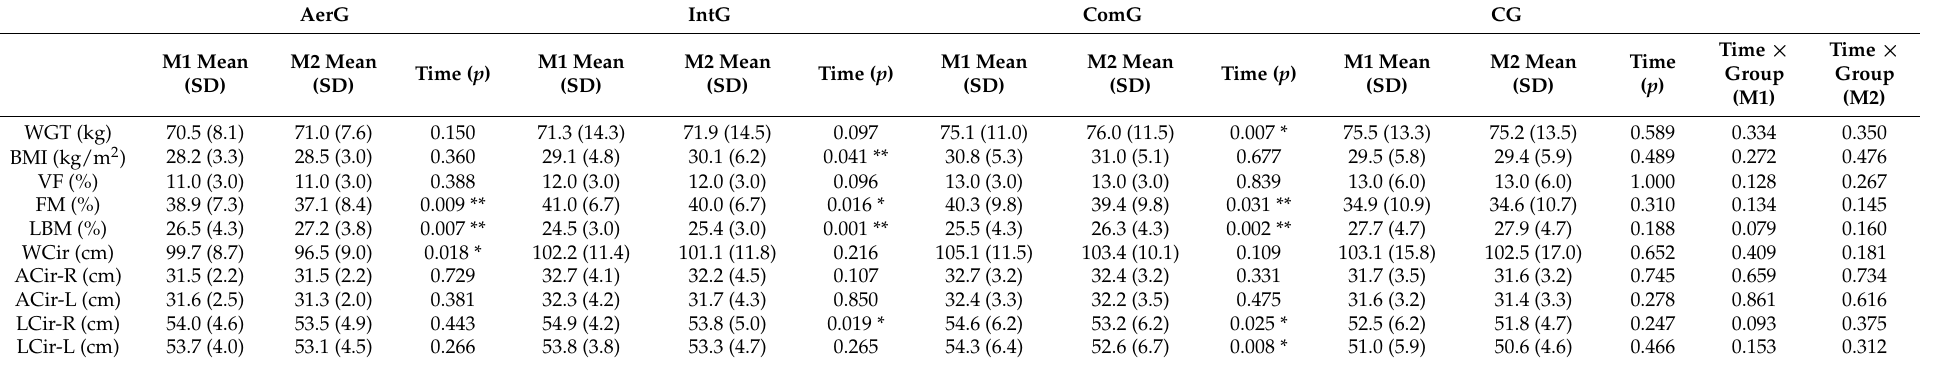
Table 2. Body composition results variation analysed by type of aquatic exercise program before and after intervention. AerG IntG ComG